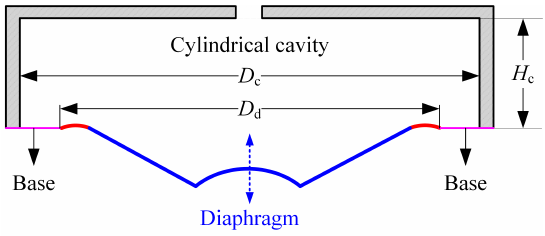
Figure 3. Schematic of the diaphragm and the cylindrical cavity.